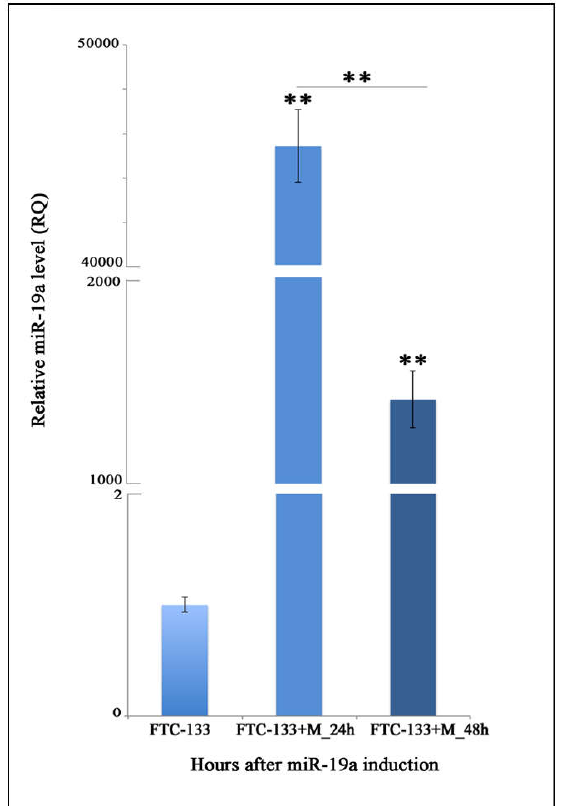
Figure 2. MiR-19a expression levels after miR-mimic overexpression. Relative quantitation (RQ) of miR-19a expression levels time course, using FTC-133 control cells as control group. U6 has been used as endogenous control. ANOVA test p value ( p < 0.0001) is reported and ** ( p < 0.01) indicates significant differences both between transfected groups and control cultures and transfected groups as reported by the post-hoc test. FTC-133+M: Cells transfected with the miR mimic.